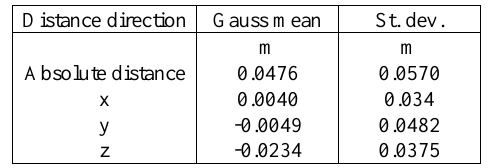
Table 1 . Values obtained after application of the Cloud-to- Cloud tool between DJI Matrice 300 L1 (compared) and P1 (reference) clouds, without the application of Cloud registration.